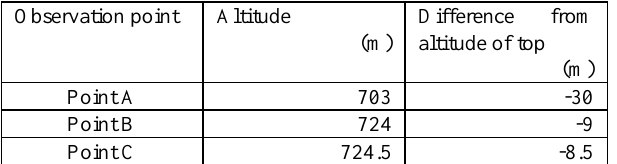
Table2. Result of single image